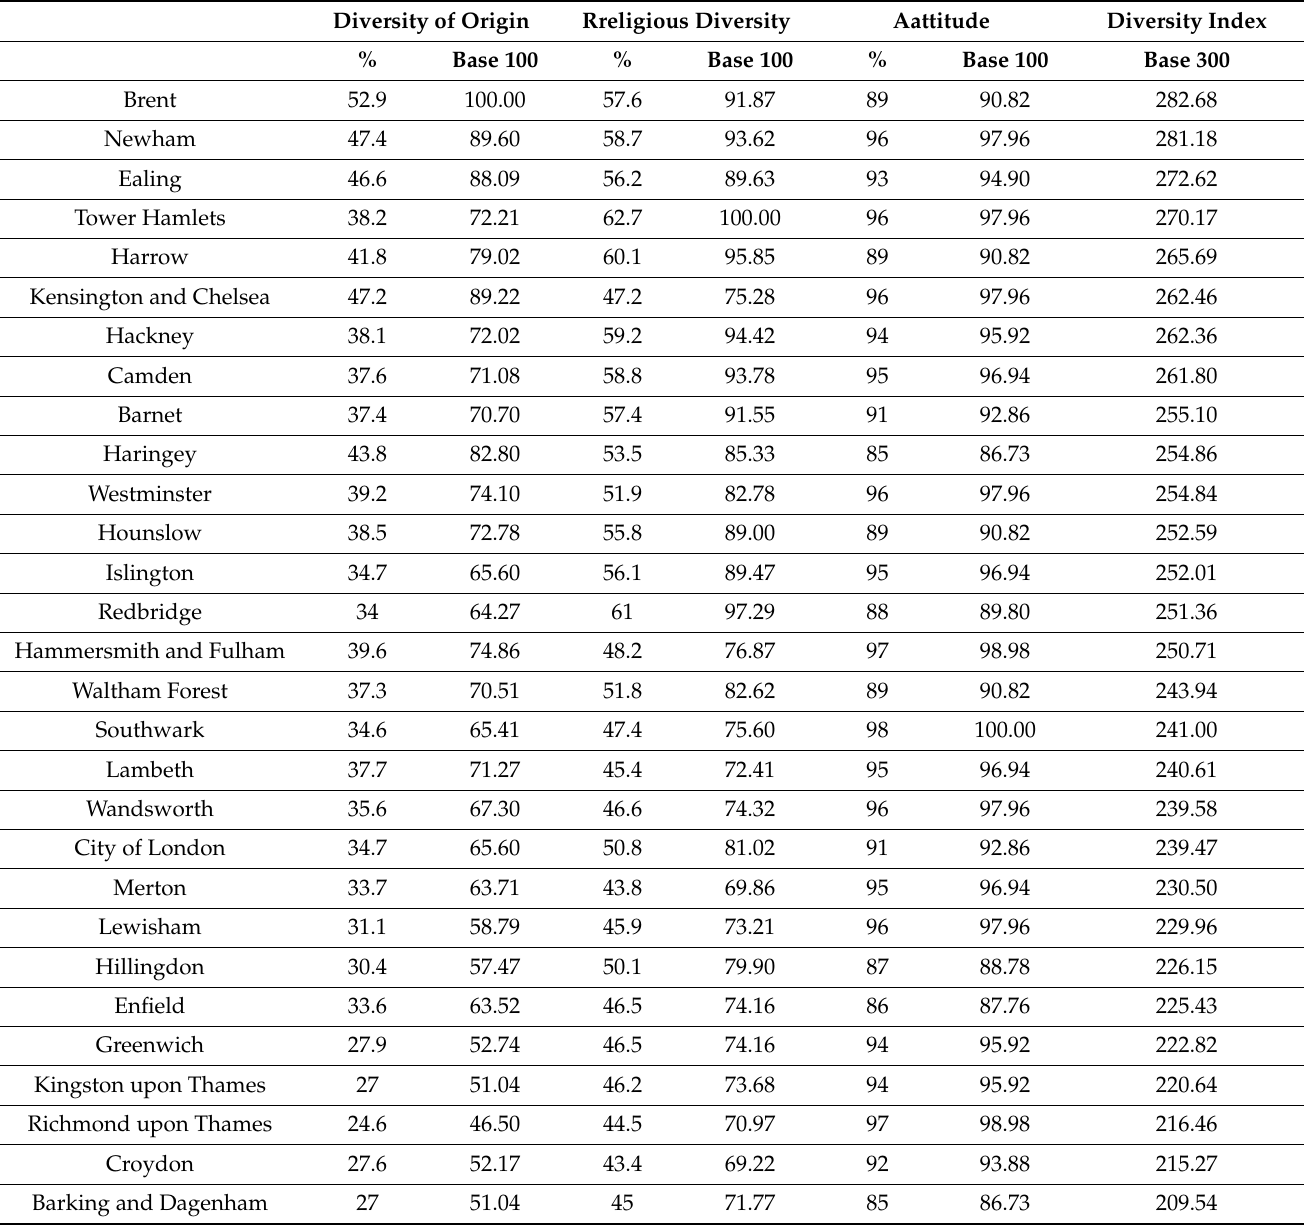
Table 5. Diversity Index—London